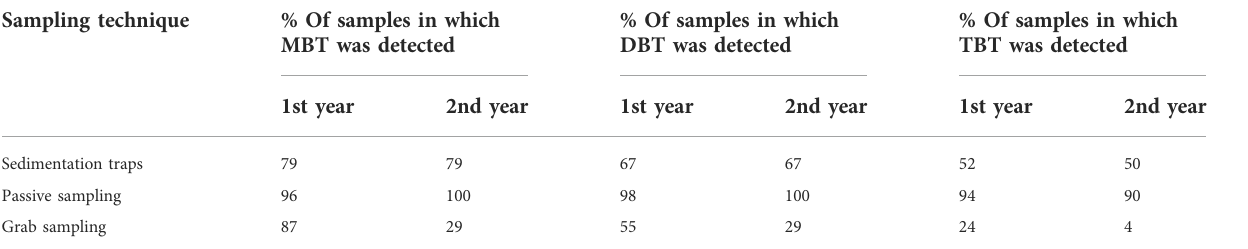
TABLE 1 Detection of BTCs with different sampling techniques. Sampling